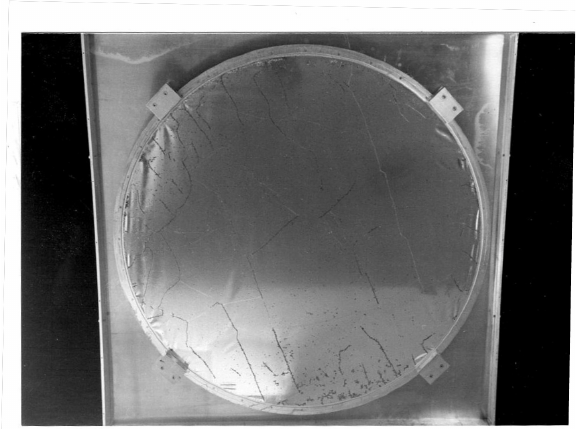
Fig. 6: Damage to floating foil caused by convection. Fig. 4: A Rayleigh-Taylor instability consists of a relatively dense fluid layer above a less-dense fluid layer.